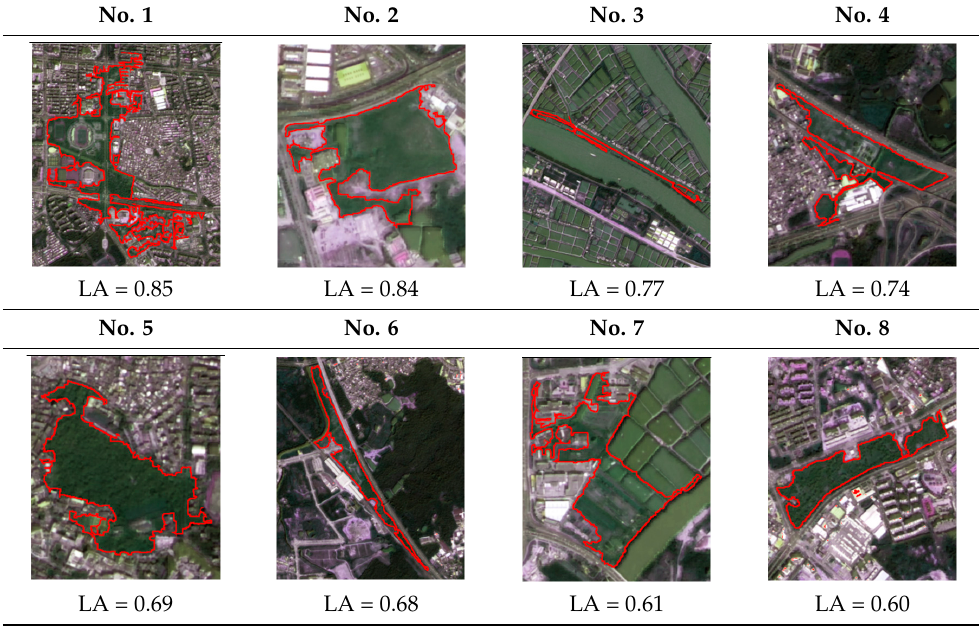
Table 13. The top 5% of UGI units for landscape activity and their measurements. No. 1